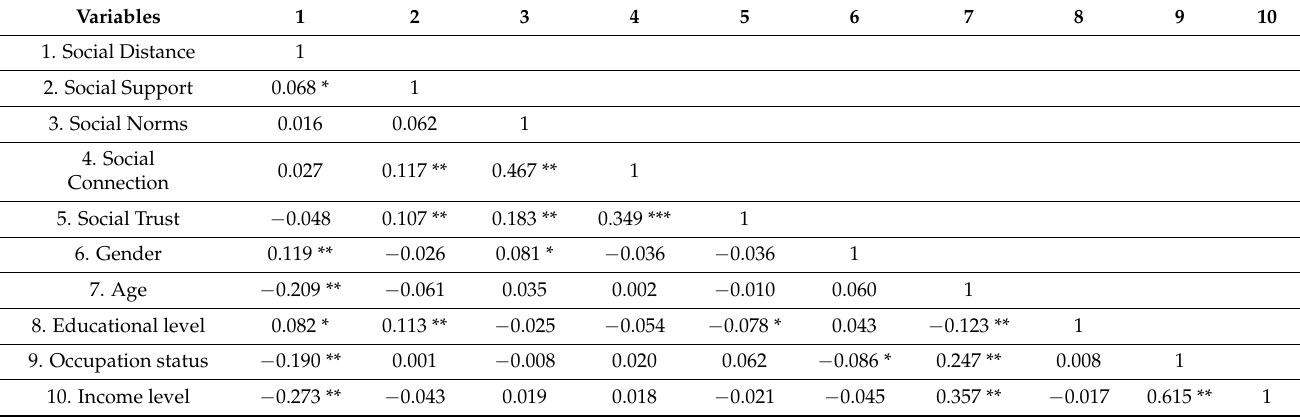
Table 3. Correlation Coefficient Matrix of Social Capital and Social Distance During the Epidemic.